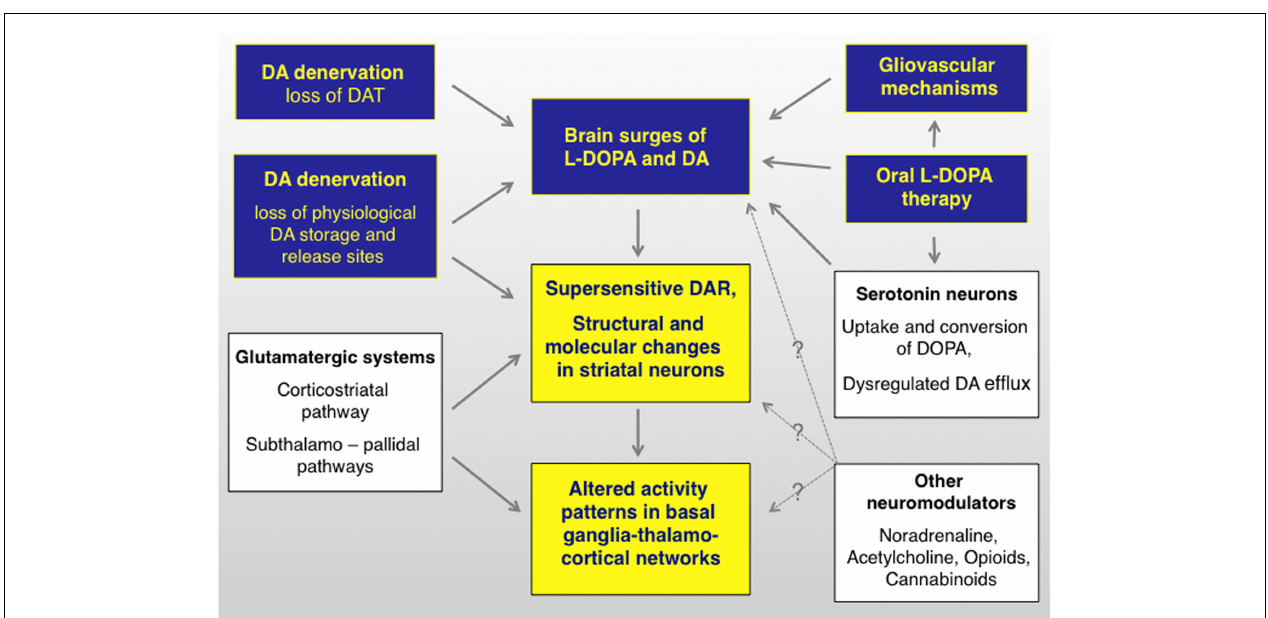
Non-dopaminergic modulatory systems are shown in white boxes. It is not well understood how these systems modulate different levels of the pathophysiological cascade (hence the question marks). DAR, dopamine receptors. Studies supporting this pathophysiological cascade have been reviewed in Ref. (3, 27, 174, 175). An updated review on the presynaptic factors is presented in this